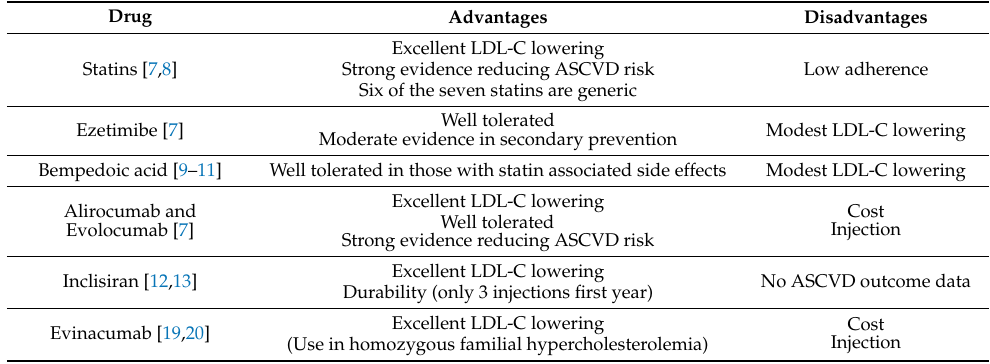
Table 2. Advantages and disadvantages of LDL-C-lowering therapies. Drug Advantages Disadvantages Statins [7,8] Low adherence